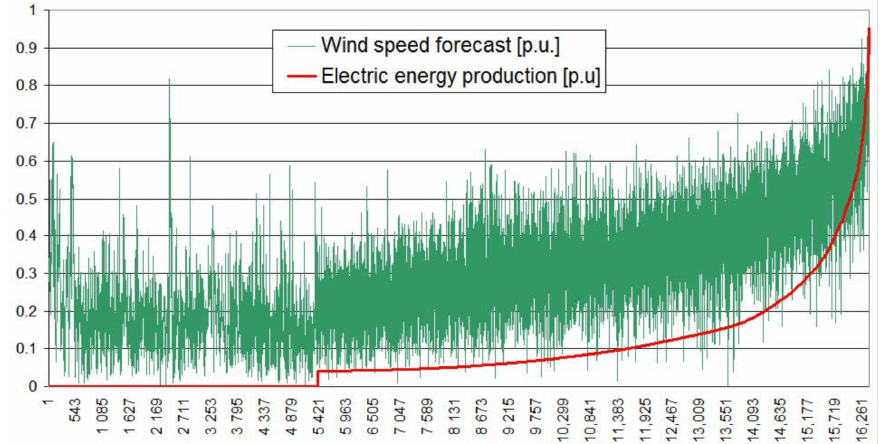
Figure 5. Correlation between hourly energy generations and wind speed forecasts. A dispersion diagram for relationships between wind speed forecasts and actual energy generation [p.u.] is presented in Figure 6. The diagram demonstrates non-linear relationships between wind speed vector’s module and production of electric energy. Data concentration is low, hence a wind turbine power curve typical of singular wind turbine is not clearly visible. This is mostly due to the differences between forecast and actual wind speeds. Extreme outliers were treated as unreliable data and were removed.